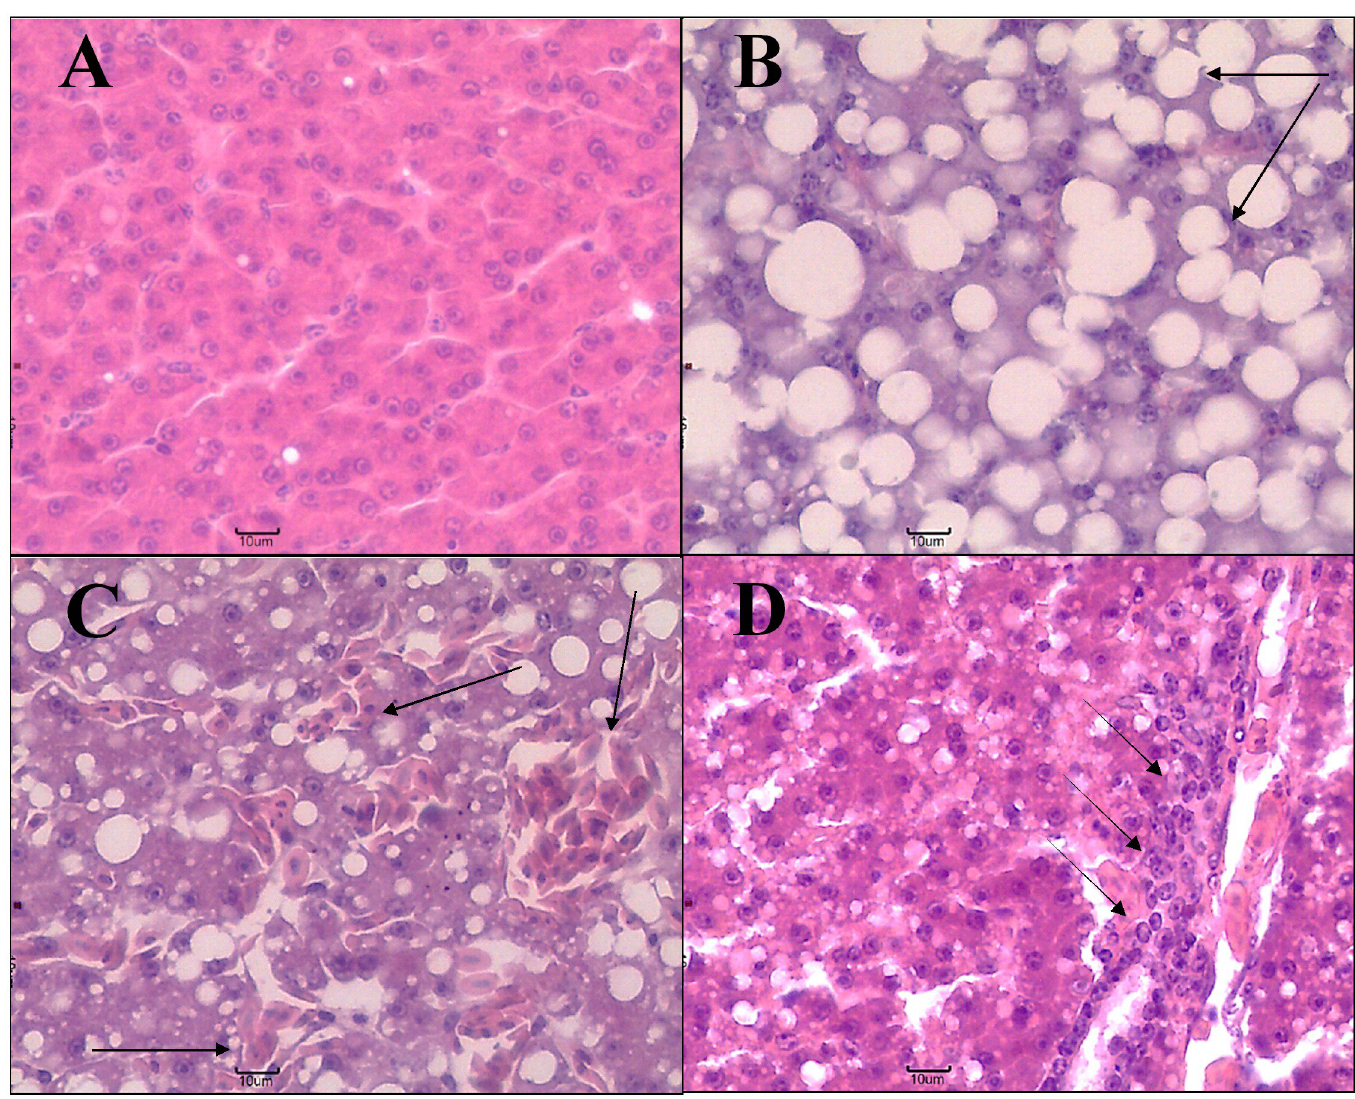
Fig 7. Example photomicrographs of quail liver 40X. (A) Normal liver, (B) liver with steatosis or fatty degeneration, (C) vascular congestion and dilatation of sinusoids, and (D) oval cell focus. Arrows point to representative examples of the corresponding alteration in the photograph.